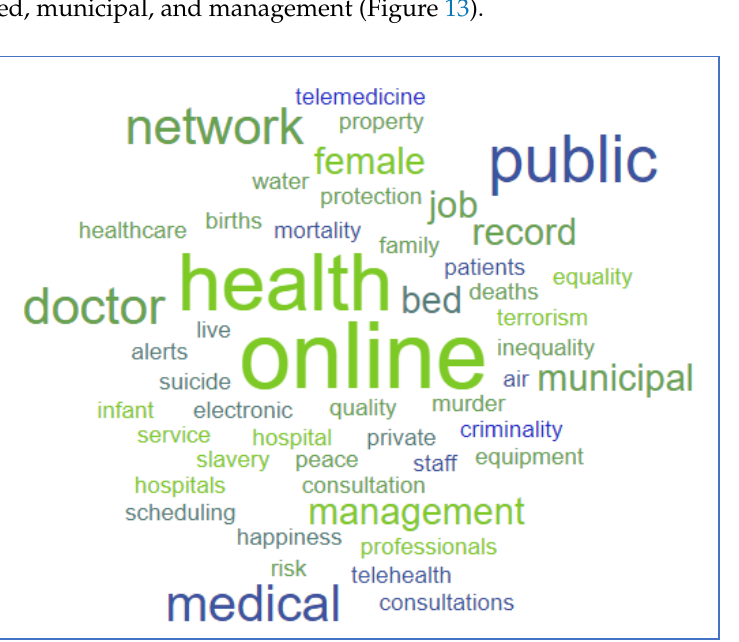
Figure 13. Most frequent indicators within the theme of “health”.